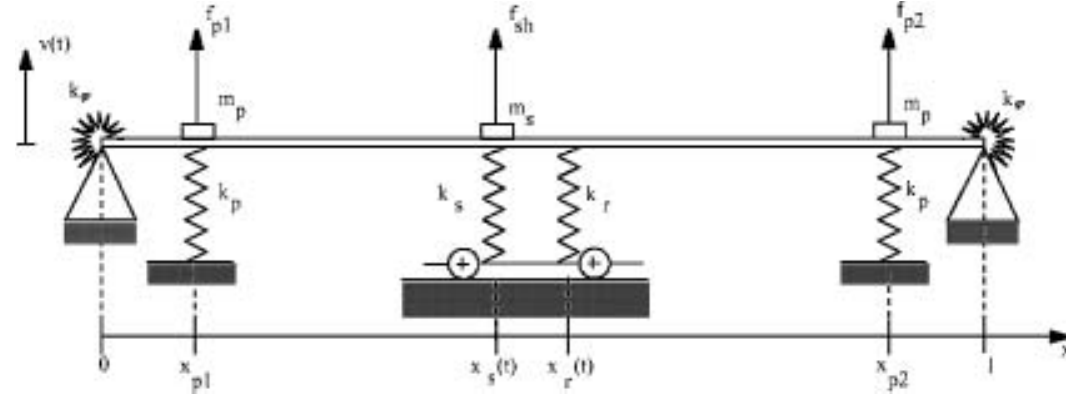
Fig. 2. Test rig mechanical model (vertical translations at ends are